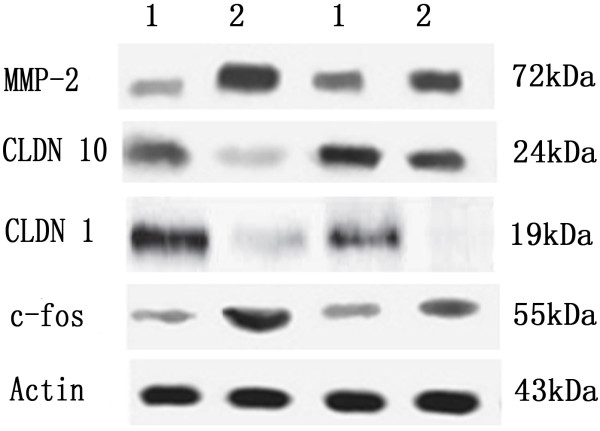
Expression of c-fos, MMP-2, claudin 1 and claudin 10 in AIS and LPA by Western blotting. The blots were subsequently probed with anti-actin antibody as a loading control. 1: AIS: adenocarcinoma in situ 2: LPA: lepidic predominant adenocarcinoma.